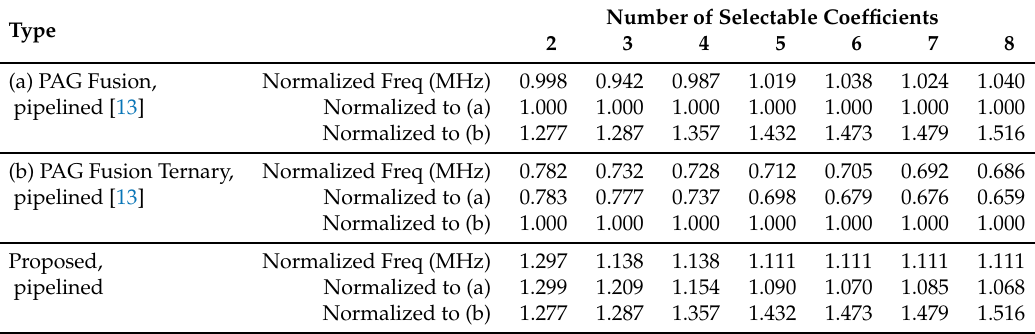
Table 16. Comparison of normalized maximum operating frequency for PAG fusion [13] and proposed (16 × 16)-bit KCMs with two to eight selectable coefficients. Proposed units can operate 14% faster on average compared to PAG fusion units with two-operand adders and 40% faster on average compared to PAG fusion units with ternary